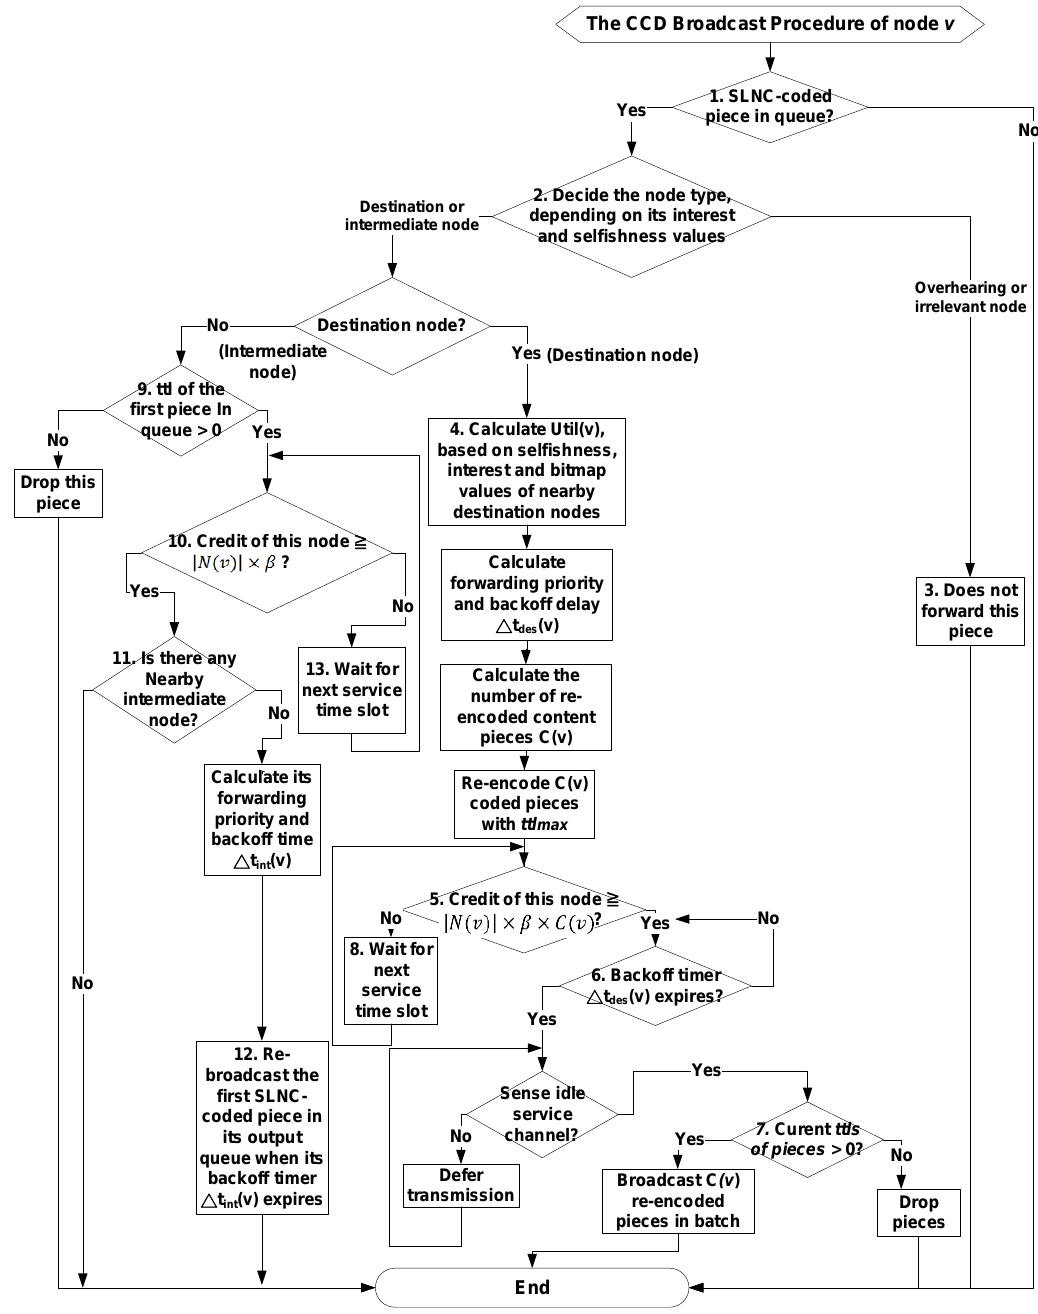
Figure 6. Flow of the CCD broadcast procedure.